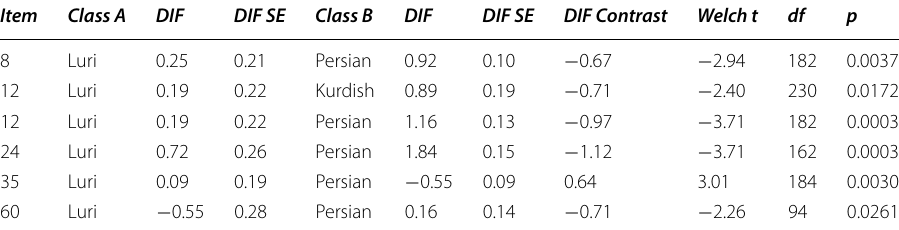
Table 7 Results of uniform DIF analysis of items (IUUESEE